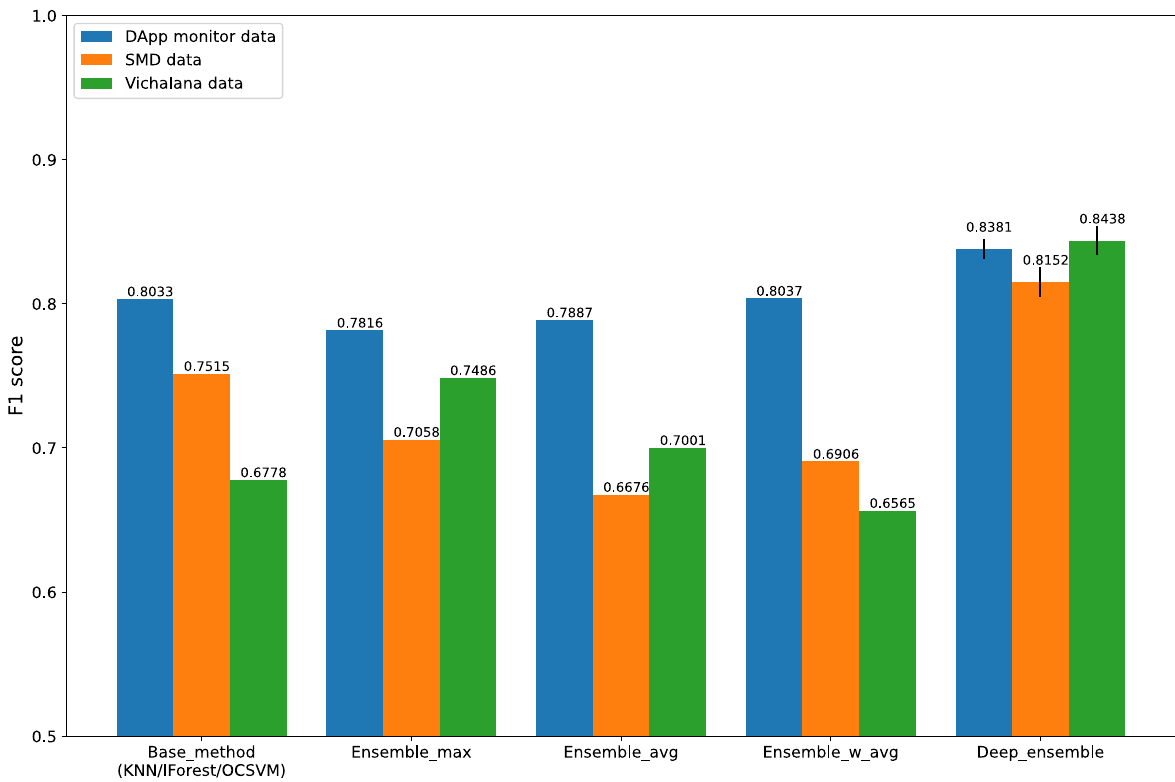
Fig. 4 Detection accuracy of methods in ELBD framework for three